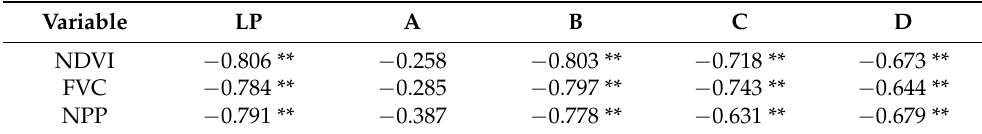
Figure 5. Variation characteristics of RSEI on the LP from 2000 to 2020: ( a ) spatial distribution of RSEI in 2000; ( b ) spatial distribution of RSEI in 2010; ( c ) spatial distribution of RSEI in 2020; ( d ) spatial variation in RSEI; ( e ) interannual variation in RSEI; ( f ) RSEI change value and change rate. Table 3. Pearson correlation coefficient of TWS and vegetation indexes in the